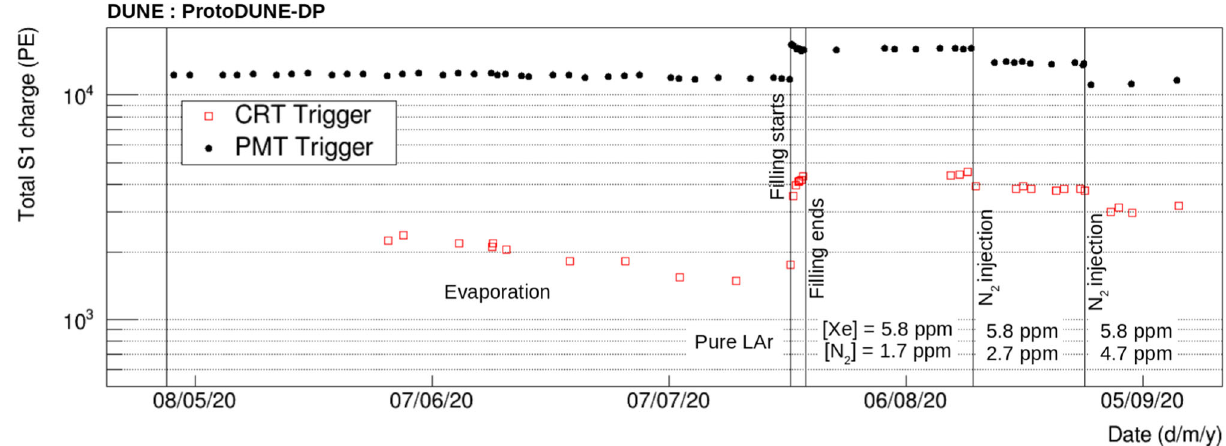
Fig. 26 Evolution of the average S1 charge per event detected in all the PMTs for PMT(CRT)-trigger data in black (red) during the evaporation, filling and N 2 injections. The processes are described in Sect.